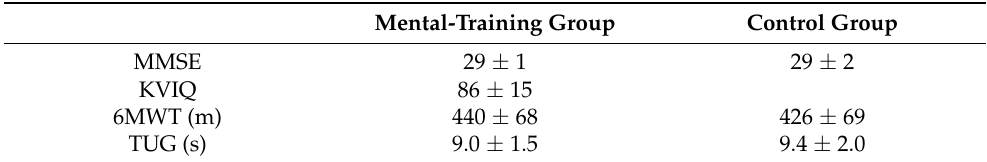
Table 1. Cognitive and functional capacities of the mental-training and control groups. MMSE: Mini-Mental State Examination. KVIQ: Kinesthetic and Visual Imagery Questionnaire. 6MWT: 6 min walk test. TUG: Timed up-and-go test. Mental-Training